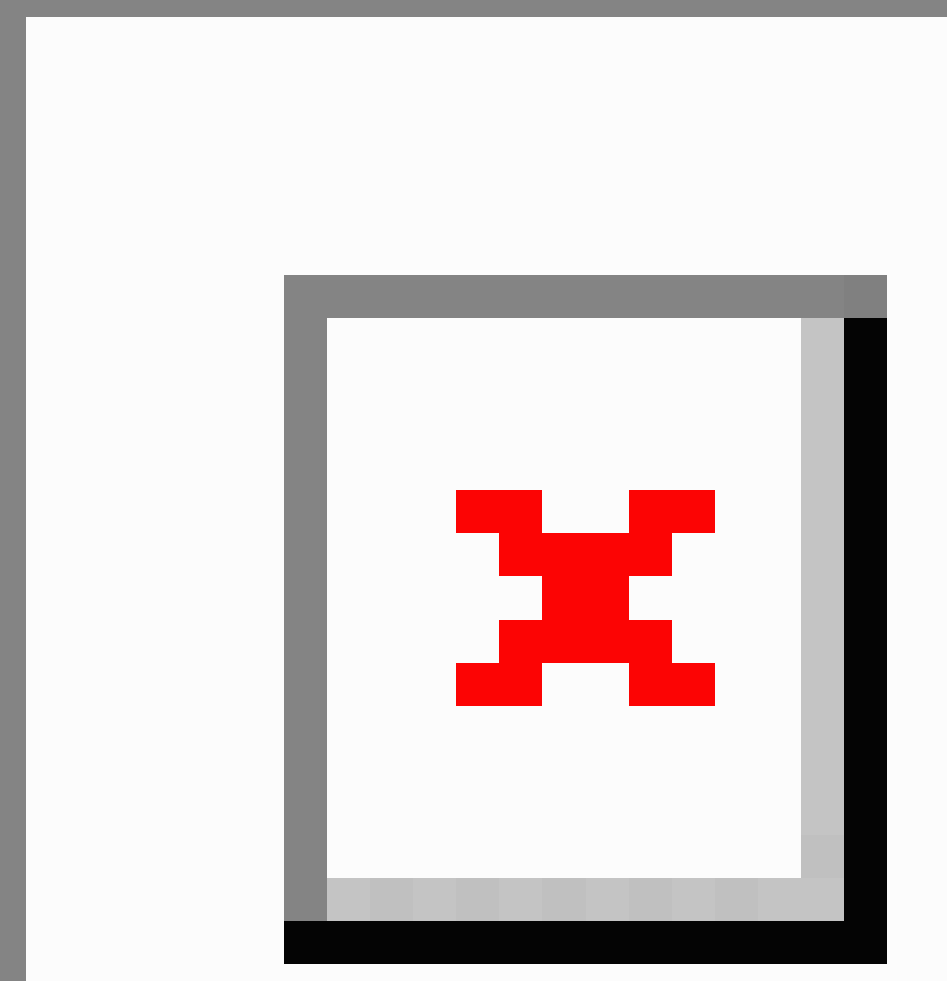
Figure 2. Number of unique providers visiting the website per week over 8